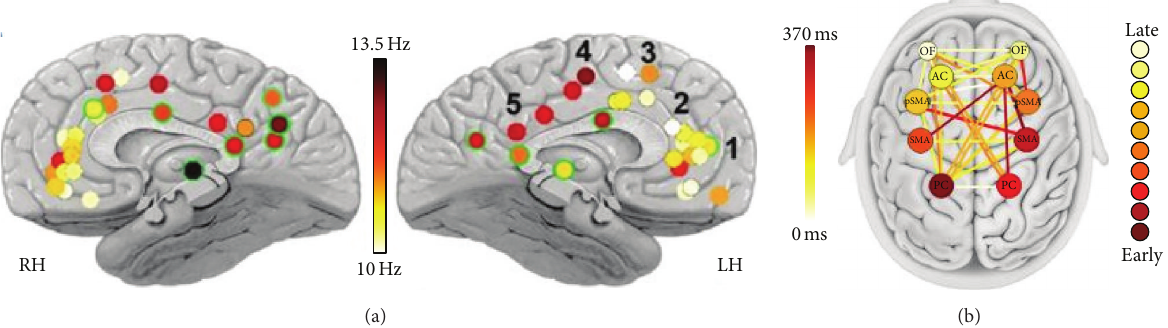
Figure 3: Fast and slow sleep spindles. (a) Average frequency of spindles across depth electrodes ( 𝑛 = 50 electrodes in 13 individuals). The color of each circle denotes the mean spindle frequency in an individual electrode according to its precise anatomical location. Green outlines mark electrodes placed more laterally than the midline. The two outliers in the medial prefrontal cortex (red circles) were the only electrode placements in one atypical individual in whom parietal spindles may be even faster than 13.5 Hz. (b) Quantitative analysis of time offsets in spindle occurrence. A graph showing the order in which spindles are detected across multiple regions (node color) and the mean temporal delays within each pair of regions (edge color). Mean order and timing across spindles for all individuals ( 𝑛 = 12 ) indicate that centroparietal spindles precede frontal spindles. Orbitofrontal cortex (OF), anterior cingulate cortex (AC), posterior cingulate cortex (PC), presupplementary motor area (pSMA), and supplementary motor area (MSA). Modified from